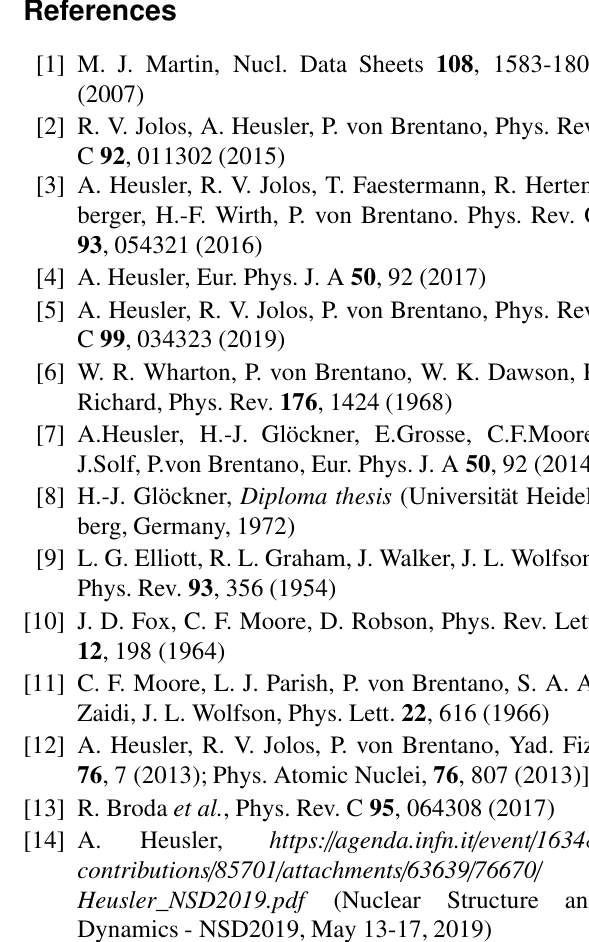
Figure 5. Comparison of level schemes for the 6 + and 12 + states at E x < 6 . 2MeV to shell model calculations with SDI [3] and M3Y [13]. (The en- ergies are shown relative to the yrast state.) The 6 + yrast and 12 + yrare states are not explained by any existing model. Two 6 + states at E x ≈ 6 . 0 MeV (1.6MeV above the yrast state) are described by the coupling of g 9 / 2 p 1 / 2 to the 3 − state. 2p2h con- figurations with spin 12 + are predicted more than 1.5MeV above the yrast state (wavy